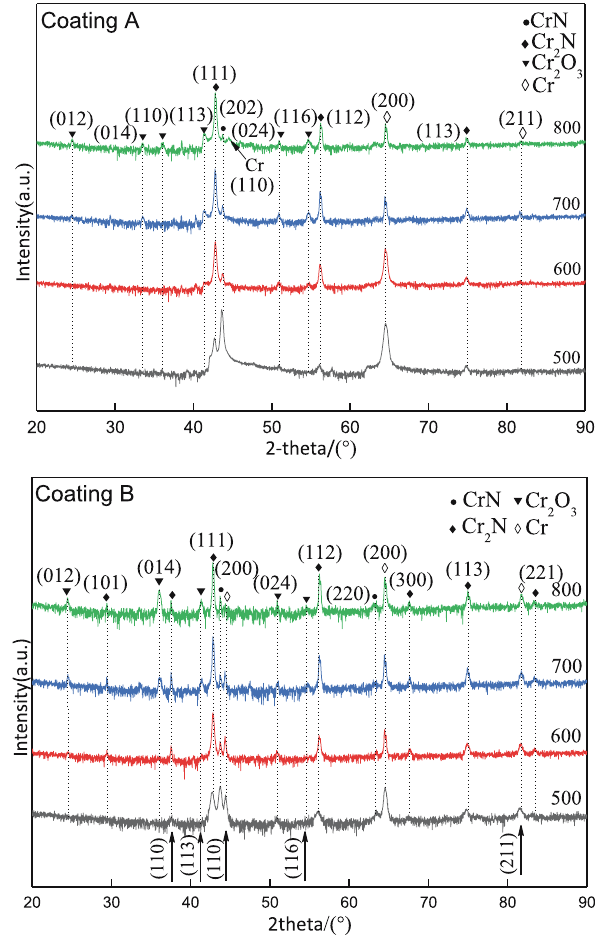
Figure 7: XRD patterns of CrN coatings oxidized at di ff erent